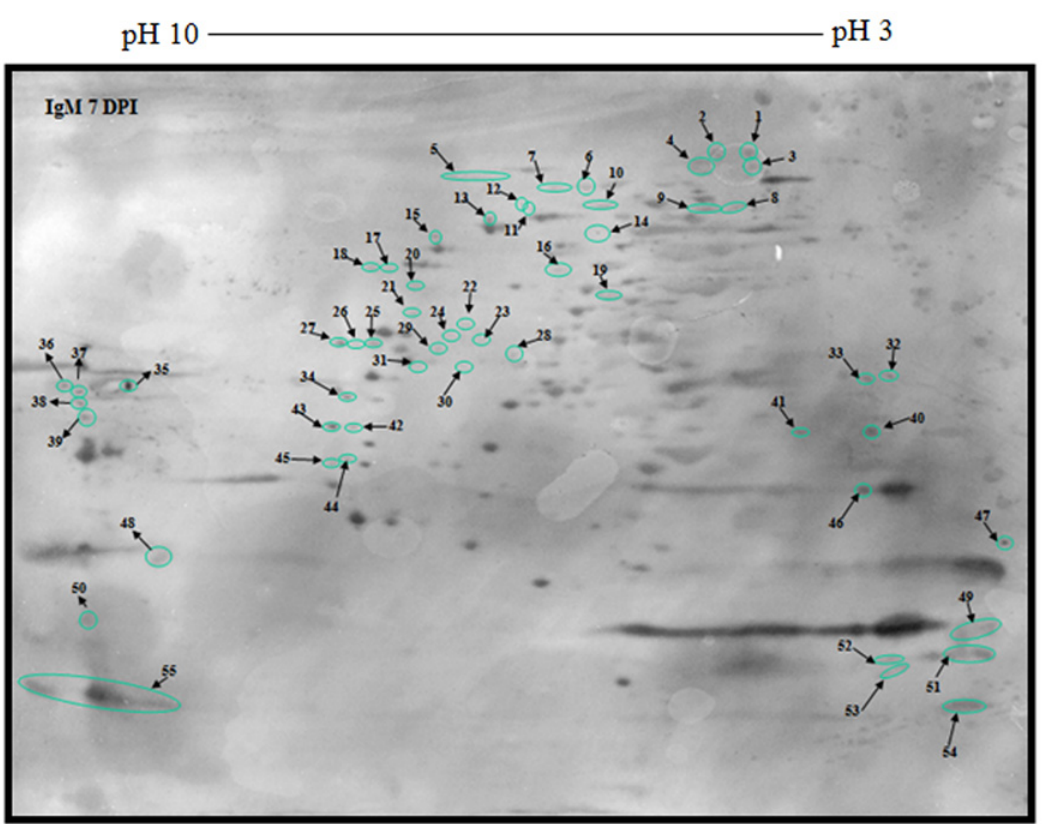
Fig 8. Immunoblot picture of unique reactive polypeptide spots of 2-DE separated T . gondii strain RH tachyzoite proteins using antibodies specific for IgM 7